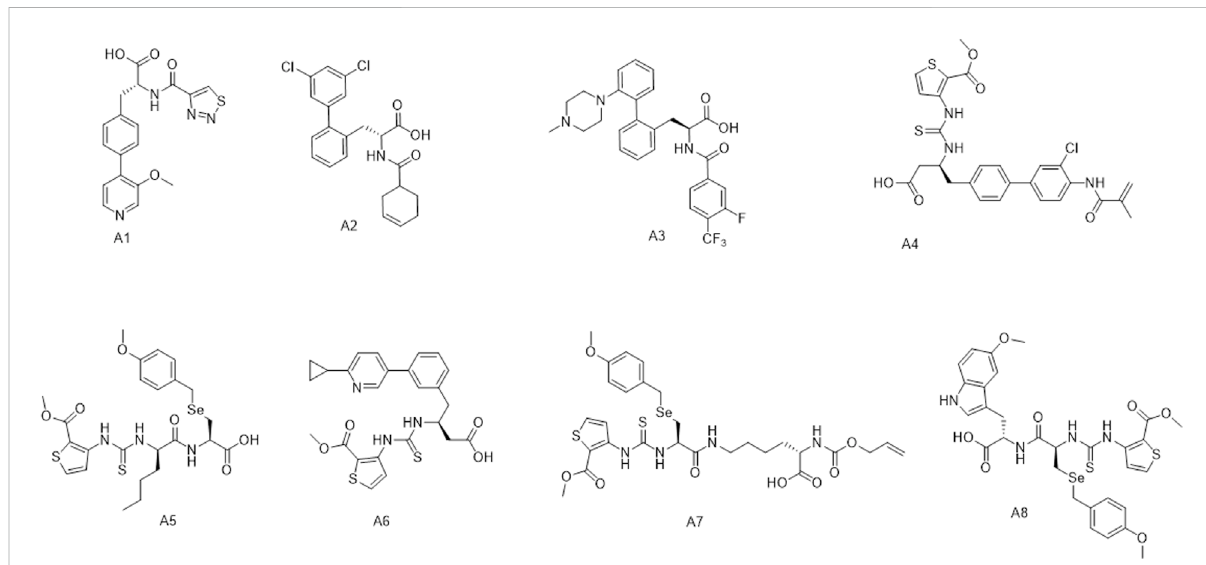
TABLE 3 Differences in docking scores for molecules generated with and without transfer learning. Docking scores Model with TL (pharmacophore)